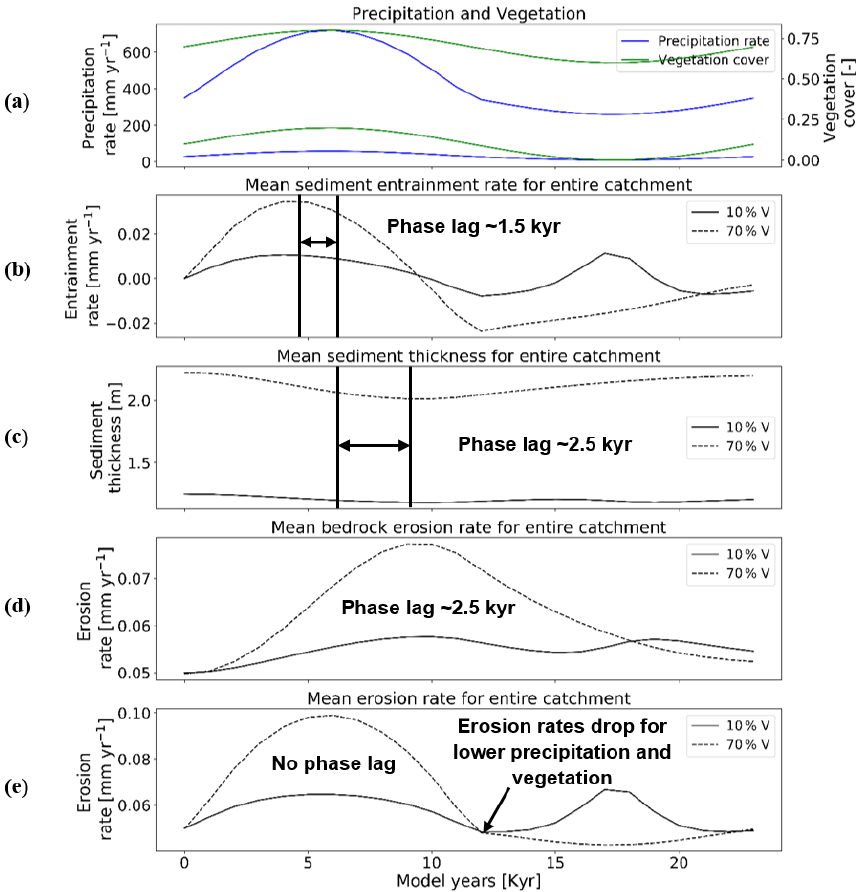
Figure 7. Temporal evolution of catchment-averaged predictions for scenario 3 described in the text (Sect. 3.3). Graphical representation of mean catchment sedimentation and erosion to (a) coupled oscillations in precipitation [mmyr − 1 ] and vegetation cover [–] in terms of (b) sediment entrainment [mmyr − 1 ], (c) sediment thickness [m], (d) bedrock erosion [mmyr − 1 ], and (e) mean erosion rates [mmyr − 1 ] for the entire catchment. The periodicity of climate and vegetation oscillations is 23kyr with a rock uplift rate of 0.5mmyr − 1